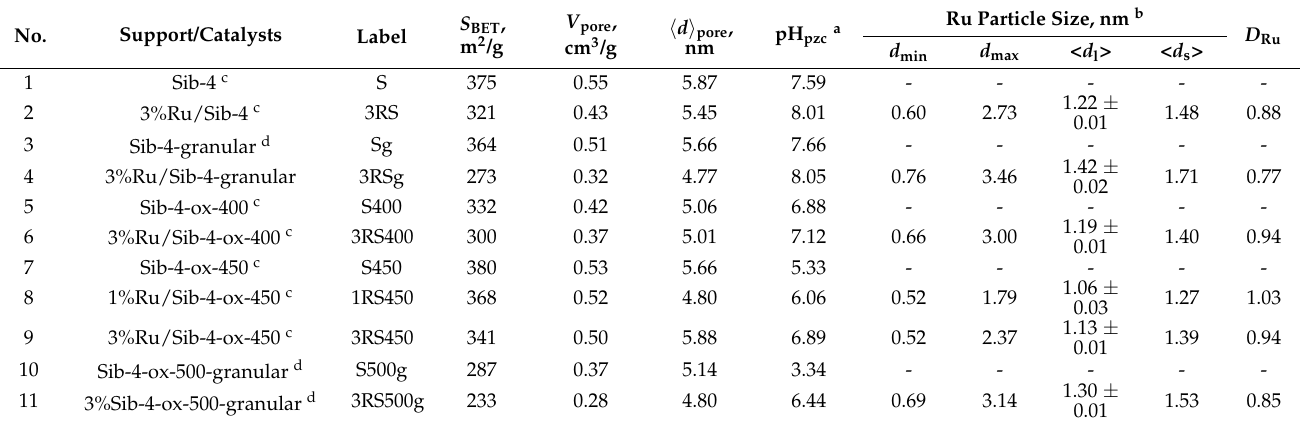
Table 1. Characteristics of the carbon supports and ruthenium